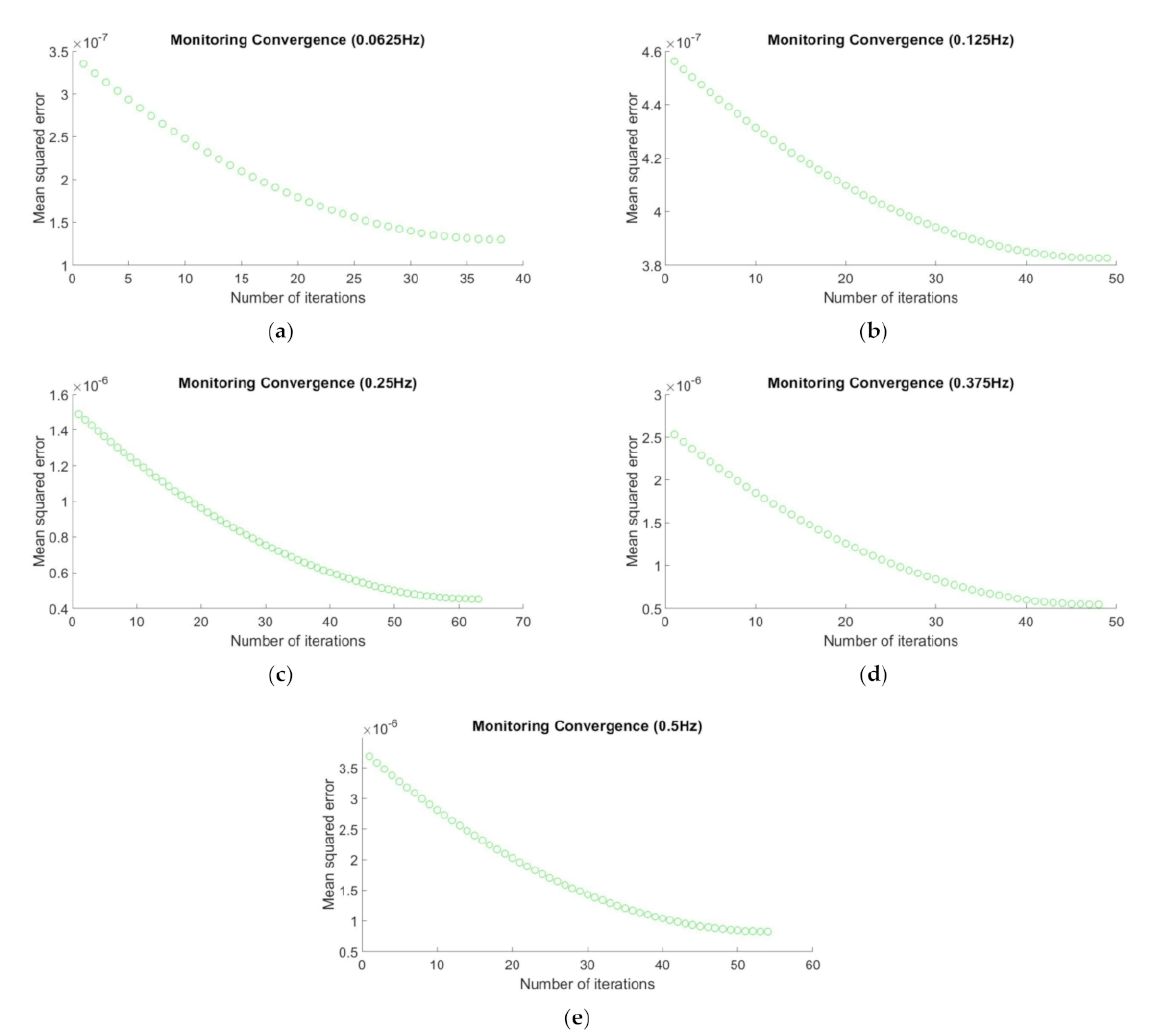
Figure 10. Mean squared error (MSE) versus number of iterations for multiple transmission frequencies (Observational